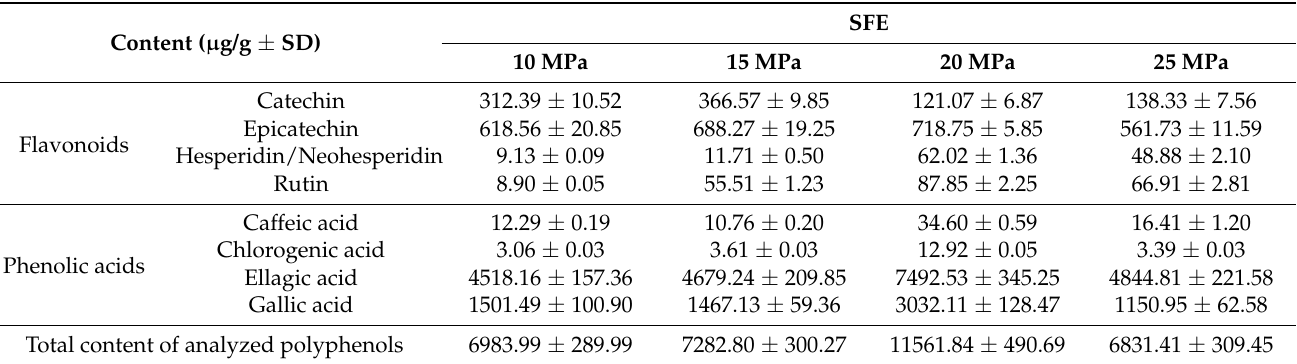
Table 3. Polyphenol components in lyophilized PP extracts obtained by supercritical fluid extraction (SFE) using CO 2 and EtOH as co-solvent at different pressures and temperature of 40 ◦